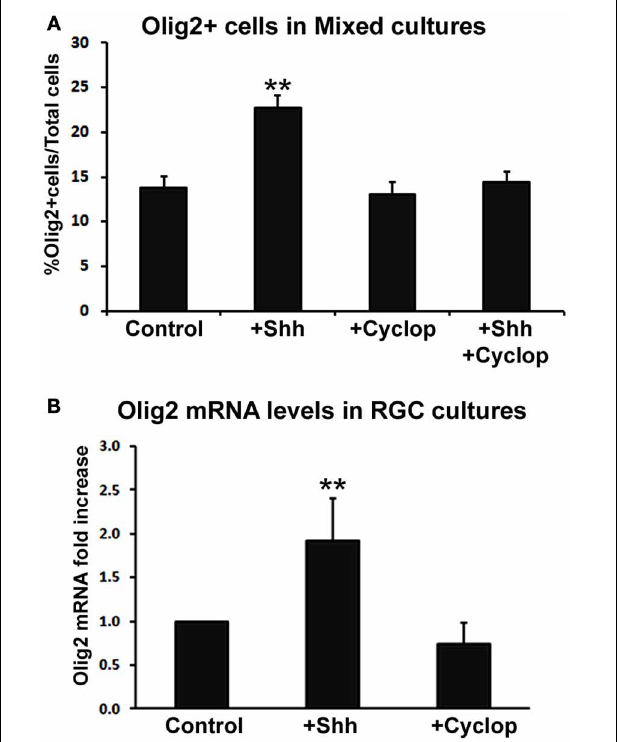
FIGURE 3 | The effect of Shh signaling on Olig2 expression in vitro . (A) Treatment with exogenous Shh significantly increased the percentage of Olig2 + cells from total cells in human cortical mixed cell cultures, whereas either cyclopamine or cyclopamine/Shh treatment did not show any effect ( n = 4; 14, 17, 18, and 19gw mixed cultures). Data are presented as mean ± s.e.m. ∗∗ p < 0 . 01 vs. control. (B) Shh signaling modulated Olig2 mRNA levels in RGC cultures ( n = 4; 14, two cases of 17 and 18gw); cyclopamine treatment did not affect Olig2 mRNA levels. Data are presented as mean ± standard deviation. ∗∗ p < 0 . 01 vs.